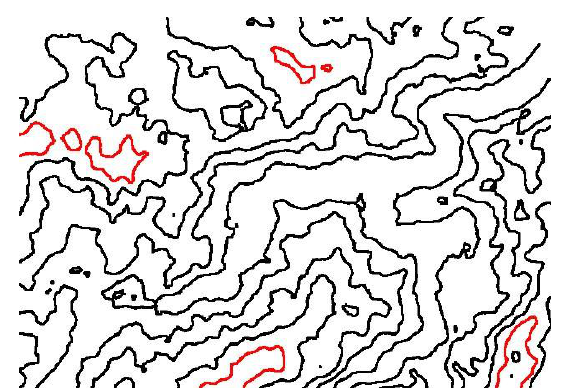
Fig.23: contour lines based on AW3D30, contour interval 50m